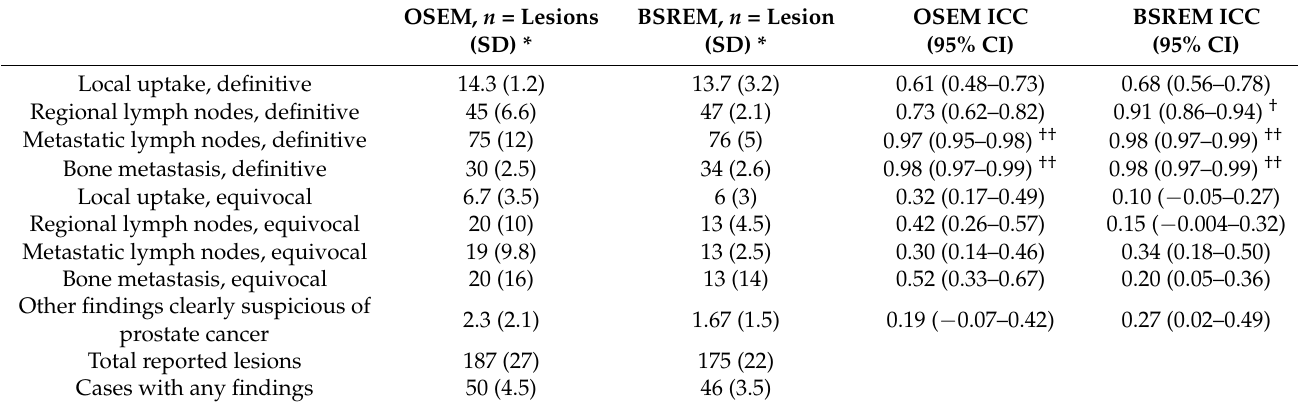
Table 2. Mean number of lesions per group in relation to the reconstruction method and intra-class correlation coefficients calculated between all three raters for each reconstruction algorithm.